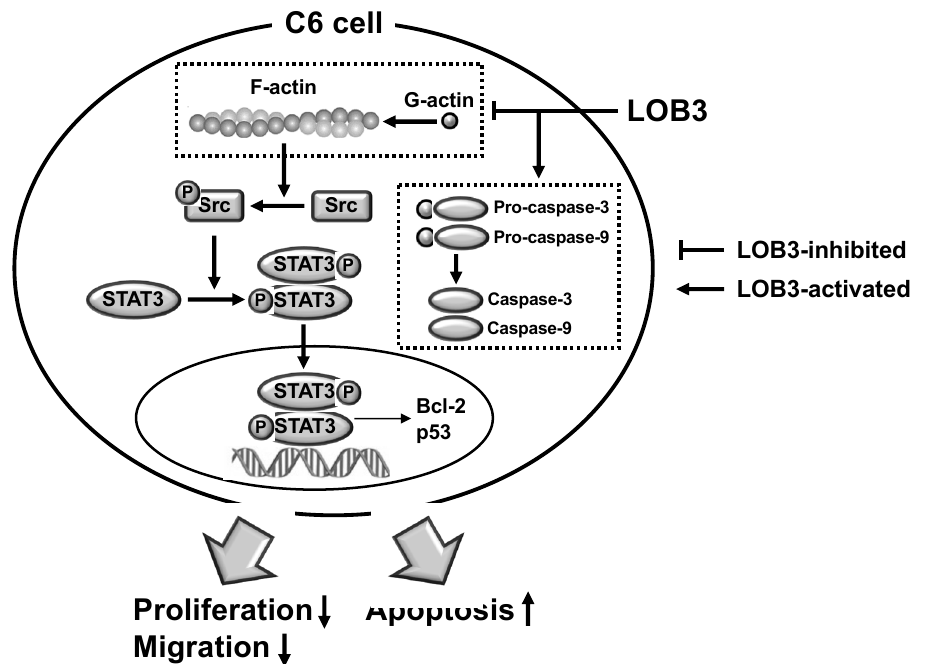
Figure 5. The proposed model to illustrate the anti-cancer activity of LOB3 in a C6 cell.